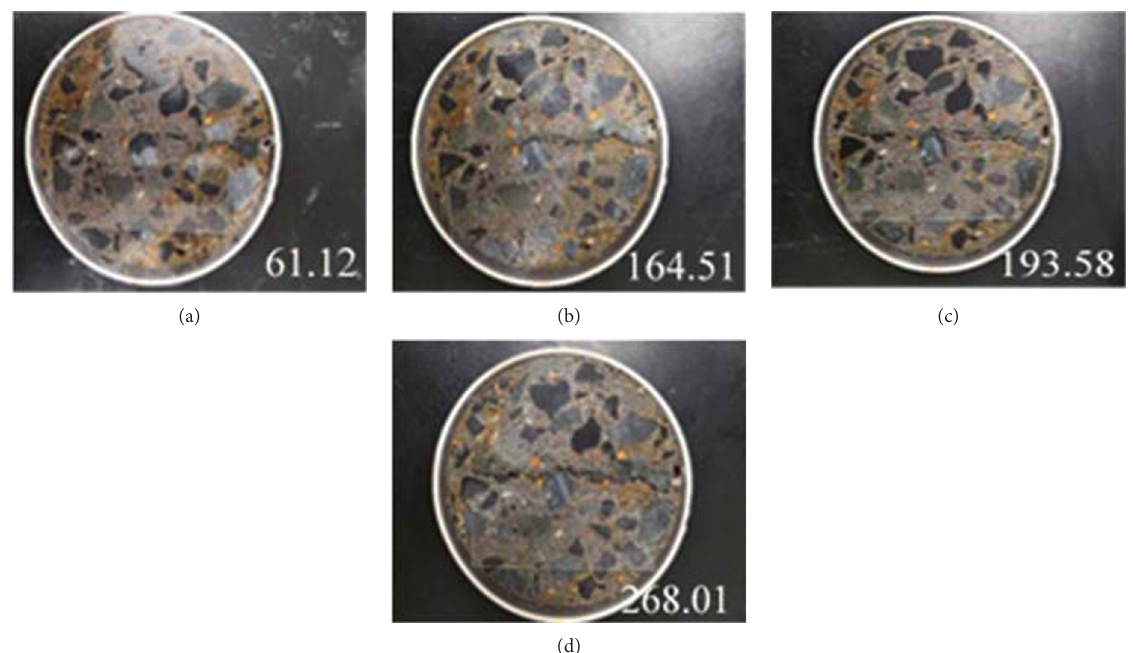
Figure 4: The development of concrete damage under different salt-freezing cycle periods: (a) 0, (b) 8th, (c) 16th, and (d) 28th cycles.